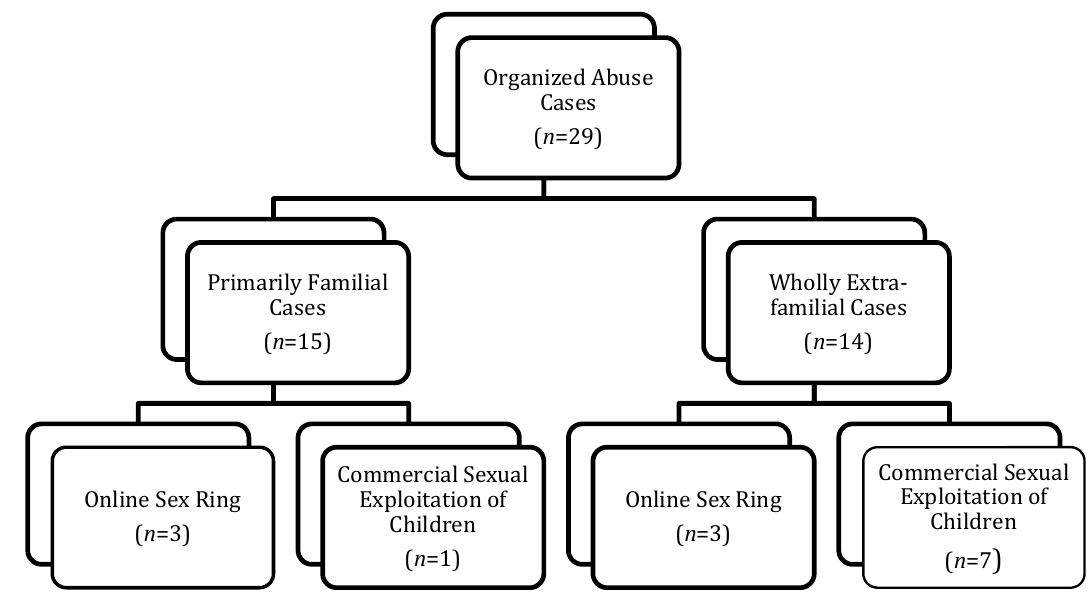
Figure 1: Types of organized abuse cases in a sample of technology ‐ facilitated arrest